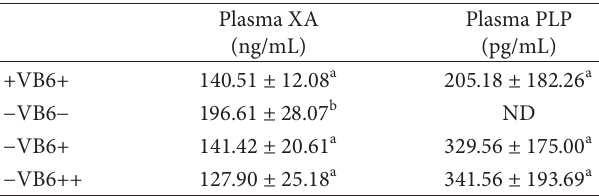
Table 2: Plasma xanthurenic acid (XA) and pyridoxal-5 󸀠 -phosphate (PLP) concentrations at the end of the vitamin B6-deficiency stage ( − VB6 − ) and the other three stages of vitamin B6: normal (+VB6+), recovery ( − VB6+), and excess ( − VB6++). Plasma XA Plasma PLP (ng/mL) (pg/mL) +VB6+ 140.51 ± 12.08 a 205.18 ± 182.26 a − VB6 − 196.61 ± 28.07 b ND − VB6+ 141.42 ± 20.61 a 329.56 ± 175.00 a − VB6++ 127.90 ± 25.18 a 341.56 ± 193.69 a Data represent the mean ± SD of seven replicates with three independent experiments. Significant difference was indicated with different letters ( 𝑃 < 0.05 ). Figure 2: Capacity of lymphocyte proliferation. The stimulation index (SI) was calculated using the following formula “proliferation of T lymphocytes incubated with ConA stimulation divided by pro- liferation of T lymphocytes incubated without ConA stimulation.” Each column data represents mean values of seven replications with three independent experiments. SI index with ∗ denotes significant differences among the groups ( 𝑃 < 0.05